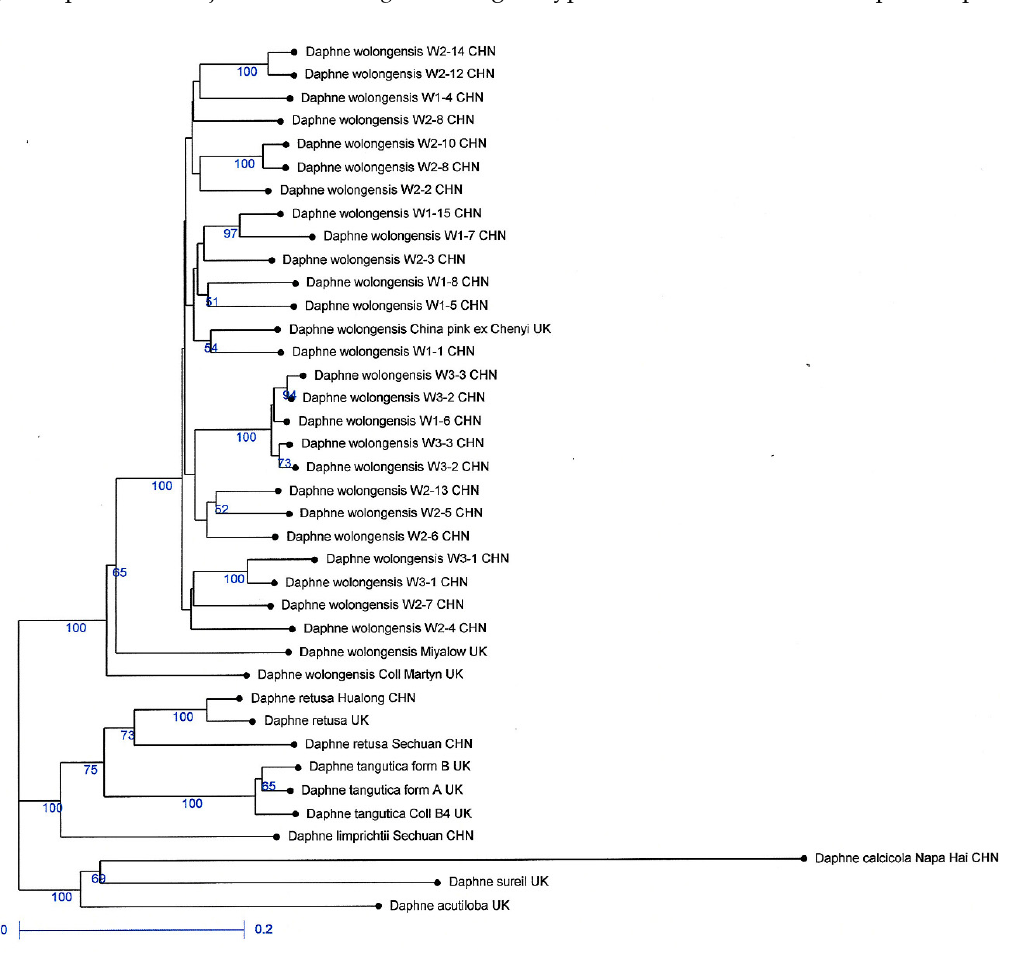
Figure 4. Cluster analysis of Daphne spp. based on a Bayesian approach. Each genotype is represented by a bar divided into K colors, where K is the number of clusters assumed in the analysis: K1—red color; K2—green color; K3—blue color; K4—yellow color. The y -axis represents posterior probability of individual assignment to genetic populations K1—K4. There is a low level of genetic diversity within the three tested populations W1, W2, and W3 (Table 2). Only the variety China Pink was identified as pure D. wolongensis . The other analyzed varieties were derived from D. wolongensis by long-lasting isolation or hybridization with other Daphne species (Table 4). PCoA also shows the level of differences between Daphne spp. and a low